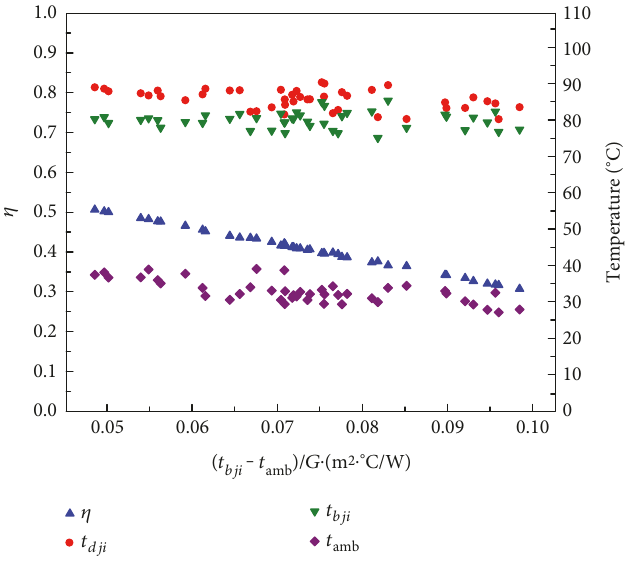
Figure 5: Field e ffi ciency of instantaneous